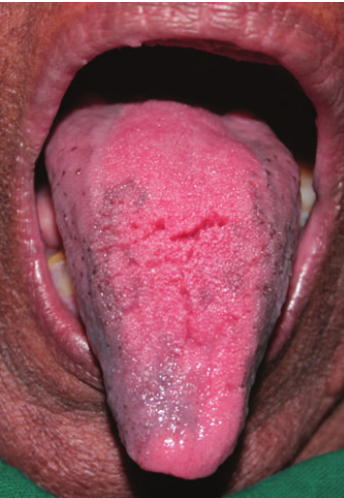
Figure 5: Papillary lesions with fissuring seen on the dorsum of tongue.